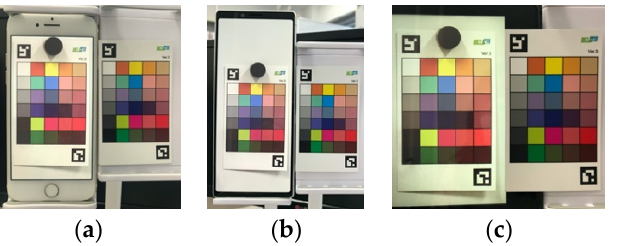
Figure 5. Color matching images displayed on each display.